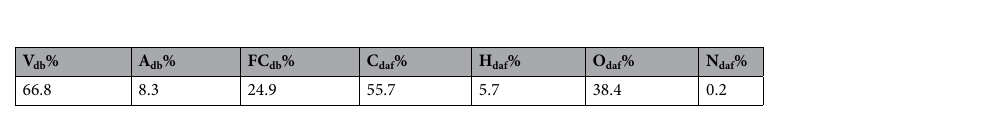
Table 1. Proximate and ultimate analysis of D. linearis. V volatile, A ash, FC fixed carbon, HHV higher heating value, db dry basis, daf dry ash-free basis.